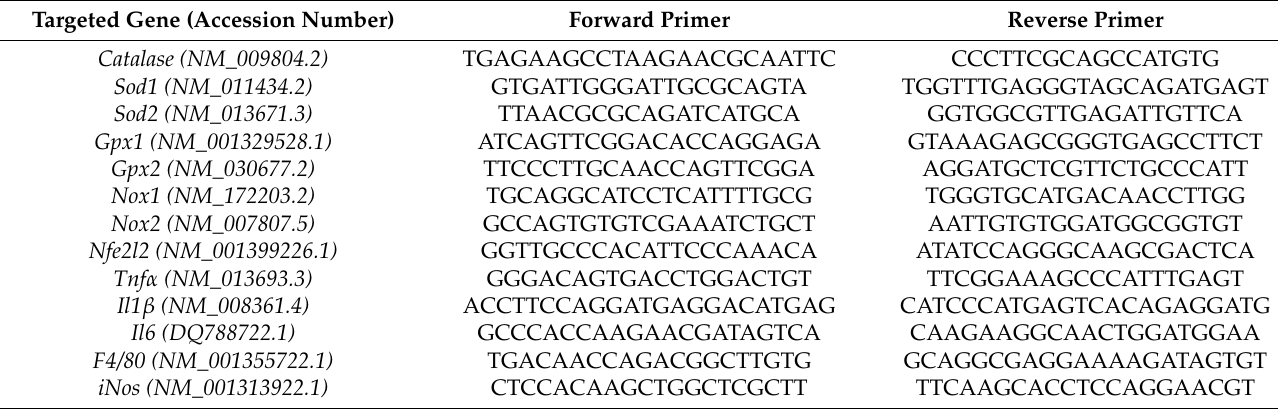
Table 1. Primers